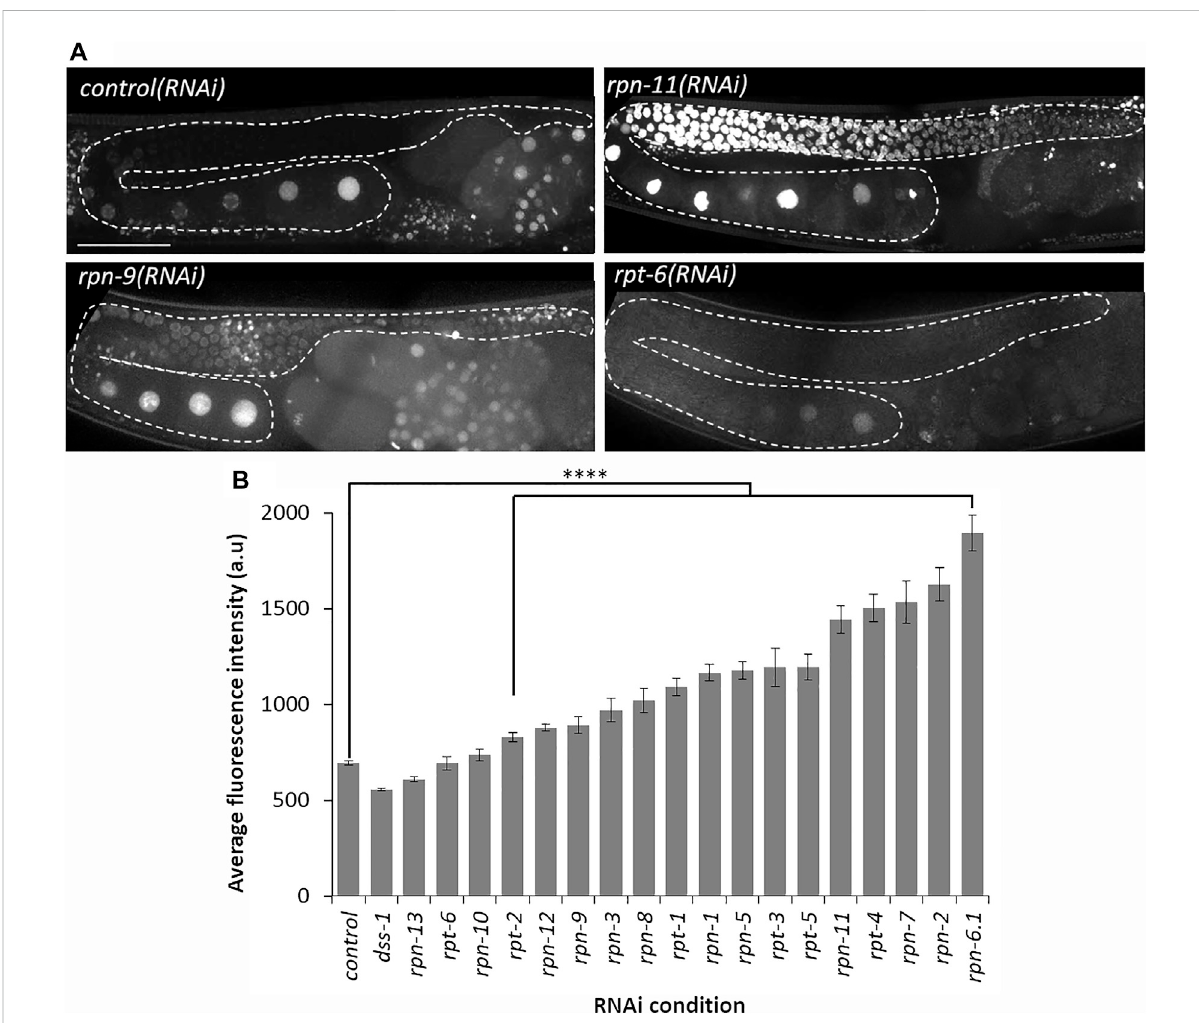
FIGURE 2 Depletion of most 19S RP subunits severely decreases proteolytic activity. (A) Representative images of germ line from Ub(G76V)::GFP::H2B animals treated with the indicated RNAi. Representative images of normal germline proteolytic activity [ control(RNAi) and rpt-6(RNAi) ], severe dysfunction of proteolytic activity [ rpn-11(RNAi) ], and moderate dysfunction of proteolytic activity [ rpn-9(RNAi) ]. A gonad arm is outlined with white dashed lines. (B) Average fl uorescence intensity of Ub(G76V)::GFP::H2B germ lines treated with either RNAi againsta control ( n = 122) or any of the various 19 subunits of the 19S RP ( n = 10 – 52). Fluorescence intensity (a. u) was measured in the region outlined with the white dashed lines as indicated in (A) . All images taken at the same laser intensity and PMT gain, and then the same post-image modi fi cations made to each image. **** represents p -values < 0.0001 compared to control(RNAi) condition. Error bars represent SEM. Scale bar, 50